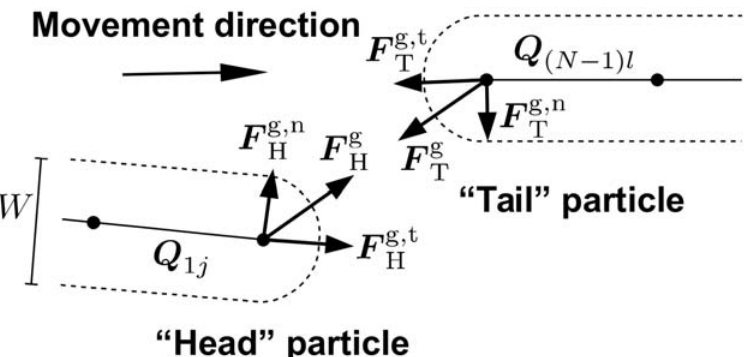
Fig 1. Short-range guiding forces between two cells in the model. Only the leading pole ( “ head ” ) of one cell (left) and the trailing pole ( “ tail ” ) of another cell (right) are shown. For clarity, the distance between the head and the tail of interacting bacteria is exaggerated. Numbering of line segments Q that connect adjacent particles on the same bacterium is shown for the case of engine direction k e = 1 (see text and [34] for notation and a detailed explanation of collision resolution algorithm). W is cell width, and d is the distance between head and tail particles of interacting